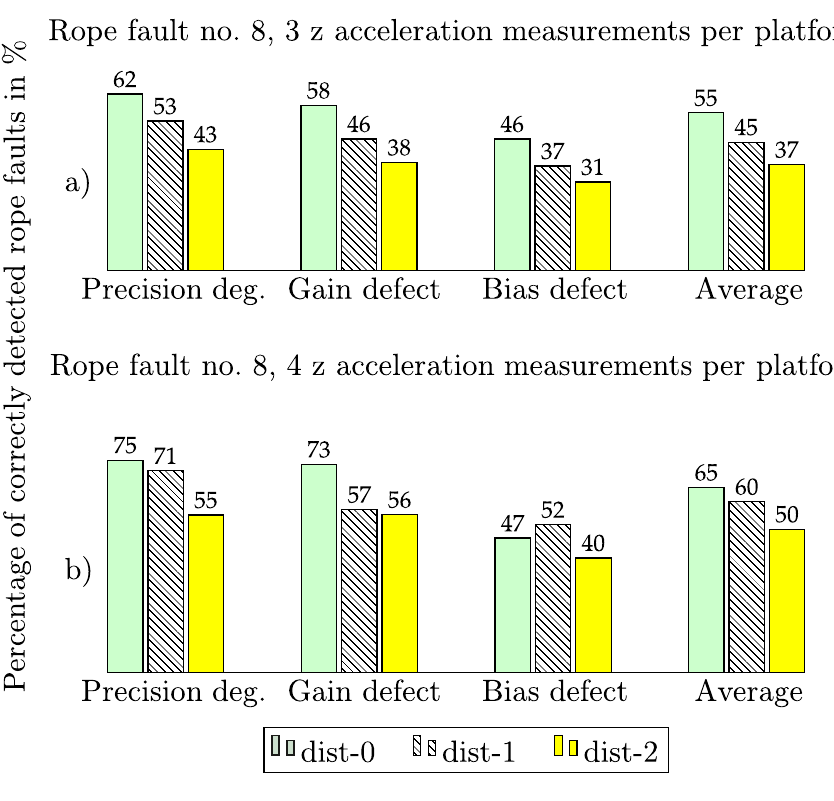
Figure 16. Percentage of correctly detected rope faults depending on the distance between defect sensors and the rope faults for a rope fault in rope number 8. ( a ) 3z acceleration sensors and ( b ) 4z acceleration sensors per platform are